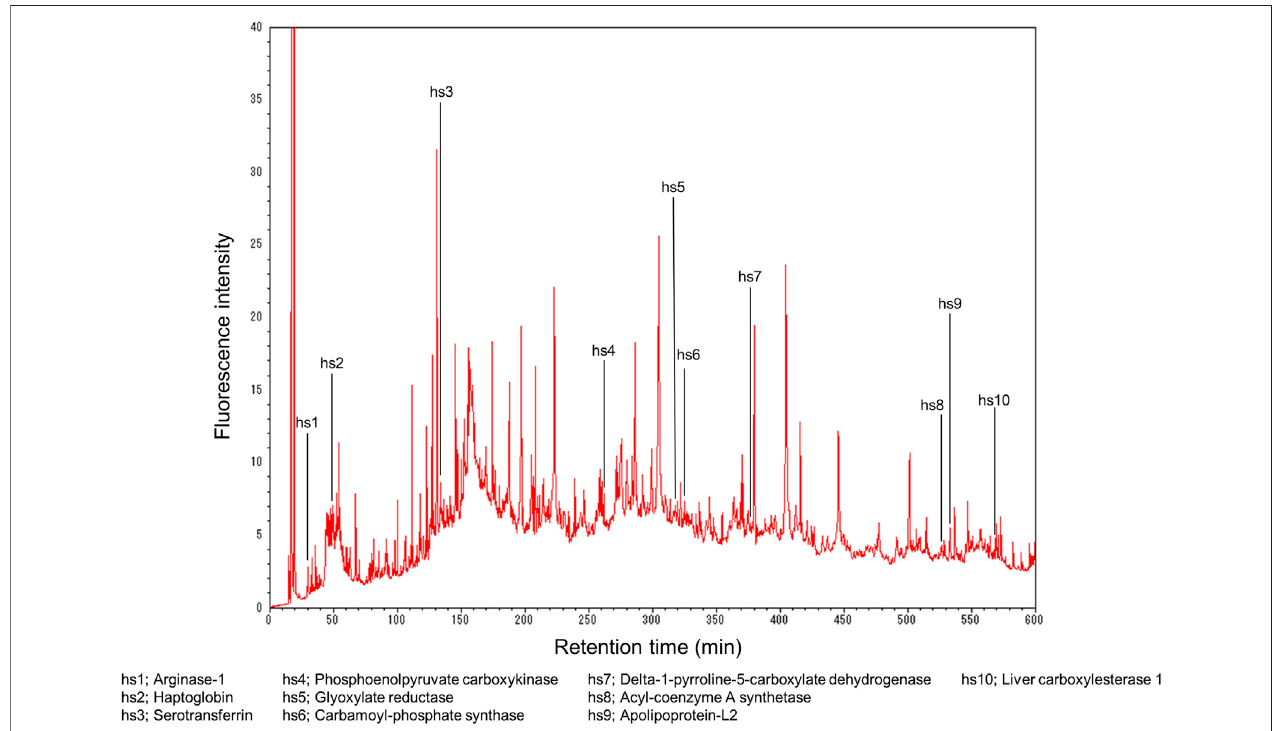
FIGURE 2 | Fingerprint analysis of hepatocyte cell proteins. Reprinted with permission from Nakata et al. (2015).